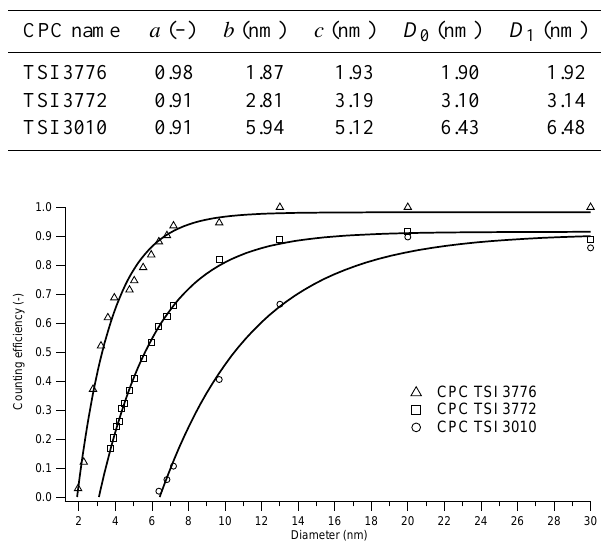
Fig. A1. Counting efficiency curves (Eq. A1) as a function of the mobility diameter for the CPCs used to determine the initial GR (particles with D p < 6nm).